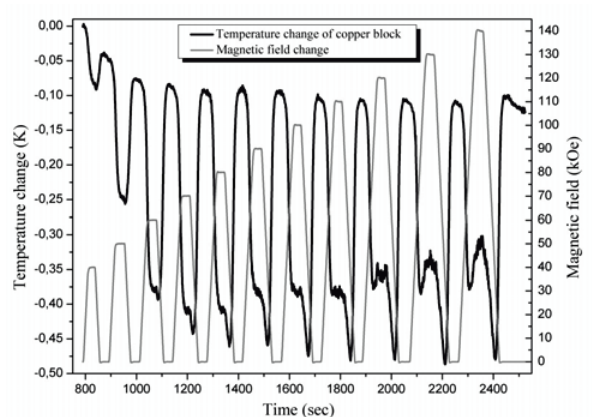
Figure 8. The time dependence of magnetic field change (gray curve) and a corresponding temperature change (black curve) of the copper block. The initial temperature is 273 K.